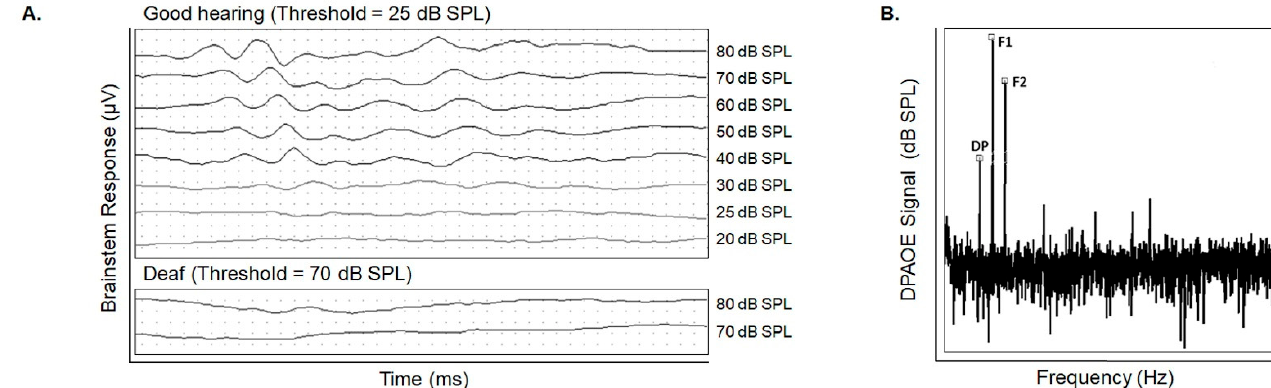
Figure 3. Sensorineural hearing loss can be assessed by auditory brainstem response (ABR) and distortion product otoacoustic emissions (DPOAE) testing. ( A ). Comparison of ABR waveforms from a mouse with normal hearing and a mouse with severe to profound hearing loss. Higher thresholds indicate worse hearing, and lower thresholds indicate better hearing. Detected ABR signals are measured in microvolts ( μ V) over time in milliseconds (ms), and hearing thresholds are determined as decibels of sound pressure level (dB SPL) based on the presented auditory stimulus. ( B ). DPOAE results showing peaks from presented stimuli (Frequency 1 [F1] and Frequency 2 [F2] peaks) and the presence of a distortion product (DP peak). The presence of the distortion product indicates that OHCs are responding properly to the noise stimulus with detected signals measured in dB SPL.